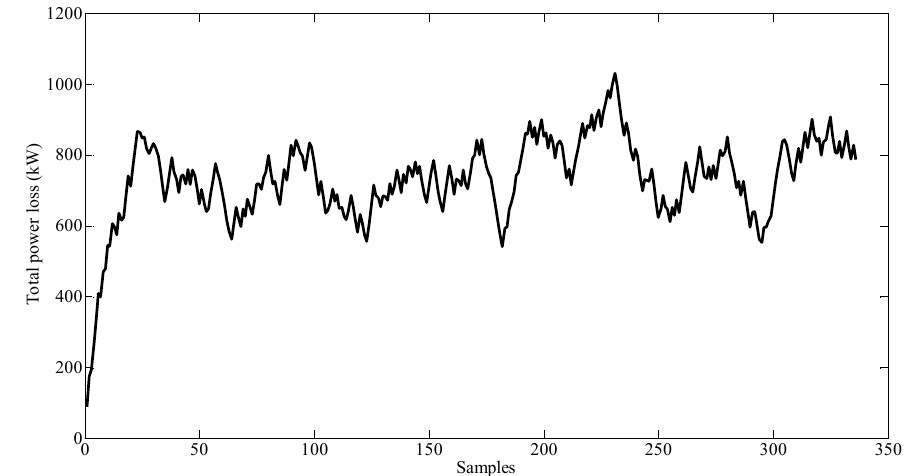
Figure 10. Optimal power loss when calculating PEV demand by maximum queuing parameters. Table 3. The simulation results for four cases of the optimization manners. The Control Variables and Objective Function Values